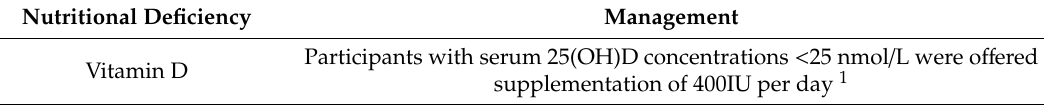
Table 1. Nutritional deficiencies and their management strategies prior to entering the intervention trial. Nutritional Deficiency Management Participants with serum 25(OH)D concentrations < 25 nmol / L were o ff ered Vitamin D supplementation of 400IU per day 1 Children with iron deficiency were o ff ered iron supplements and postponed entry into the trial after 3 months. Children were retested. A child was iron deficient when 2 of the following pools were abnormal: red cell pool Iron (haemoglobin < 111 gr / L, red blood cell distribution width > 14%), transport iron (iron saturation < 16%) and / or storage iron (serum ferritin ≤ 15 µ g / L) 1 . Criteria for treatment were according to the New Zealand Ministry of Health guidelines 2 Children with serum levels < 110 pmol / L were o ff ered the option of Vitamin B 12 prescribed supplements or dietary advice to improve